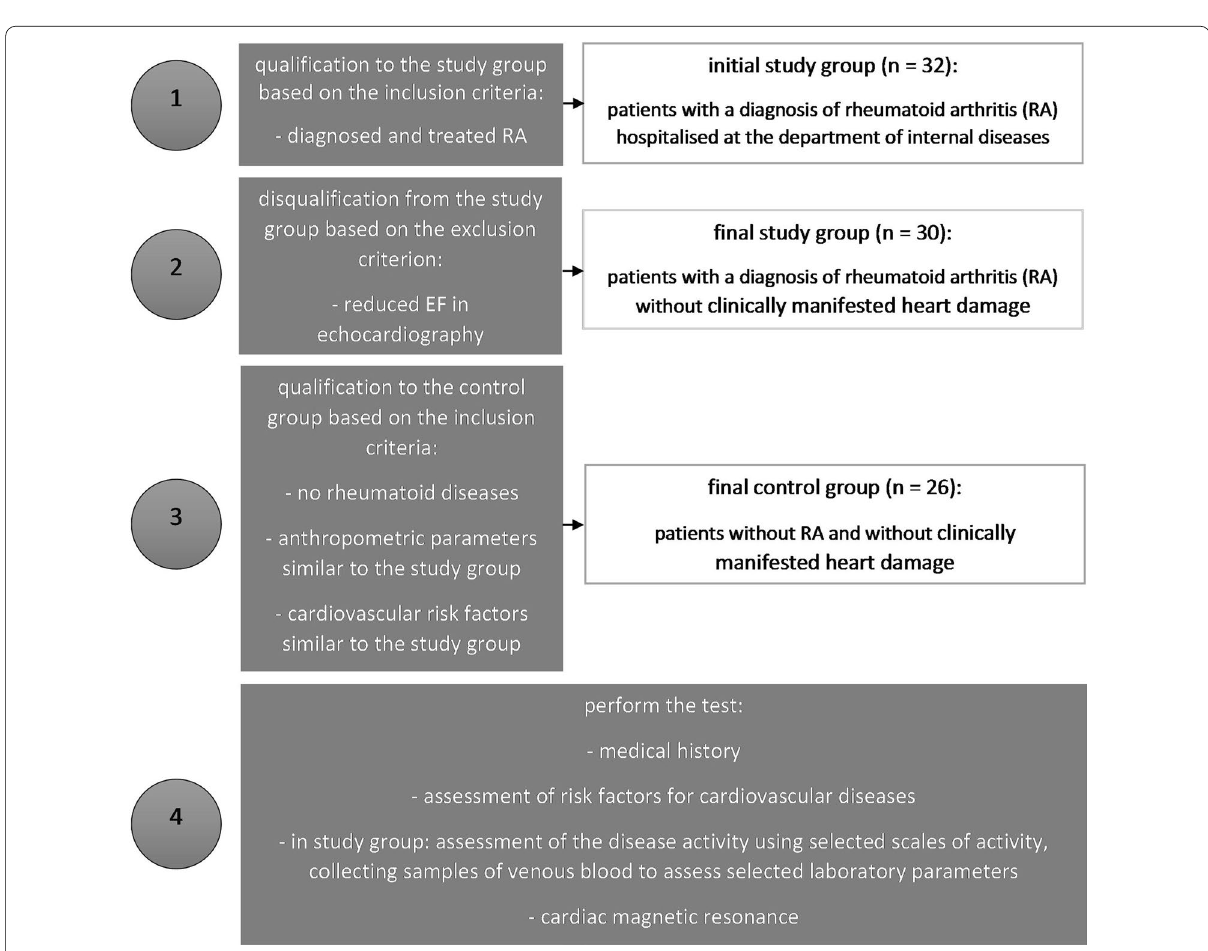
Fig. 1 The complete study